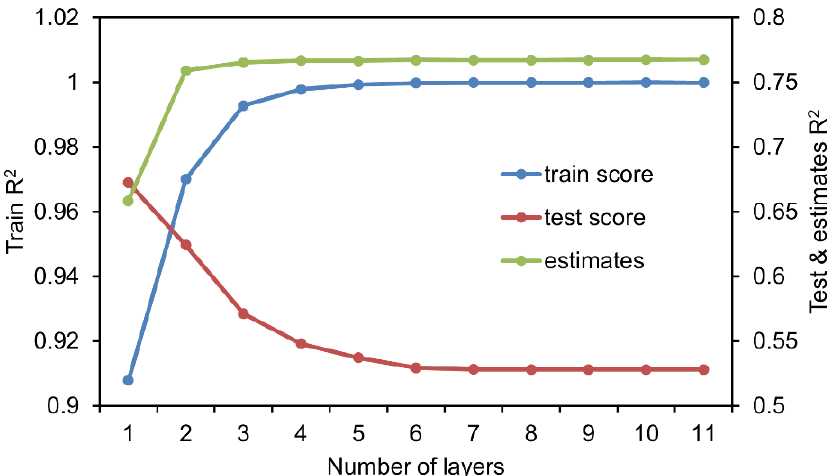
Figure 5. The relationship between the number of model layers and the fitting performance of the model. The R 2 values were the average of 10 times independent